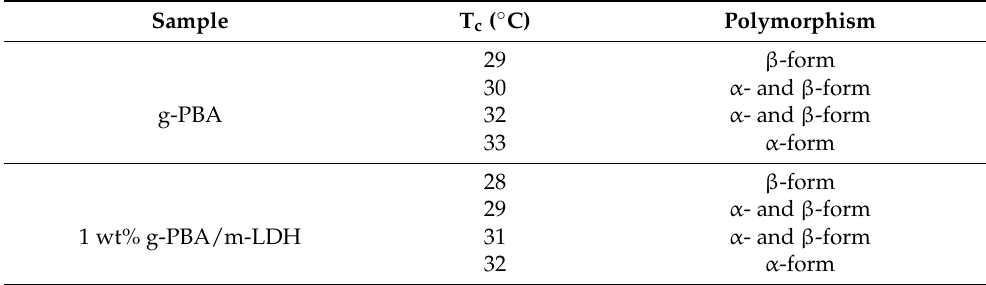
Table 3. Polymorphisms of the various g-PBAT/m-LDH nanocomposites were measured using DSC at various crystallization